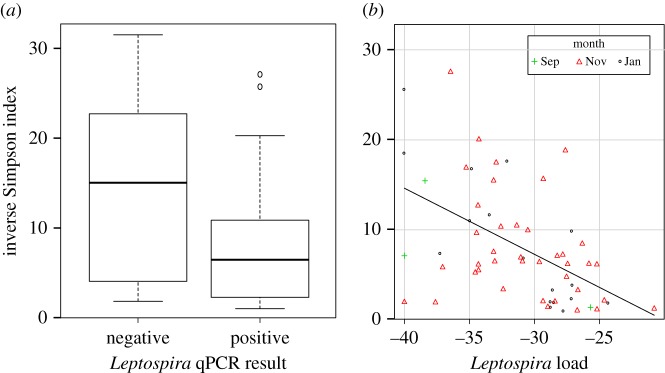
Decrease of microbiota diversity in urine of M. natalensis associated with Leptospira shedding. In (b), Leptospira load is represented by the mean Ct values (in negative form) for qPCR-positive Leptospira samples.